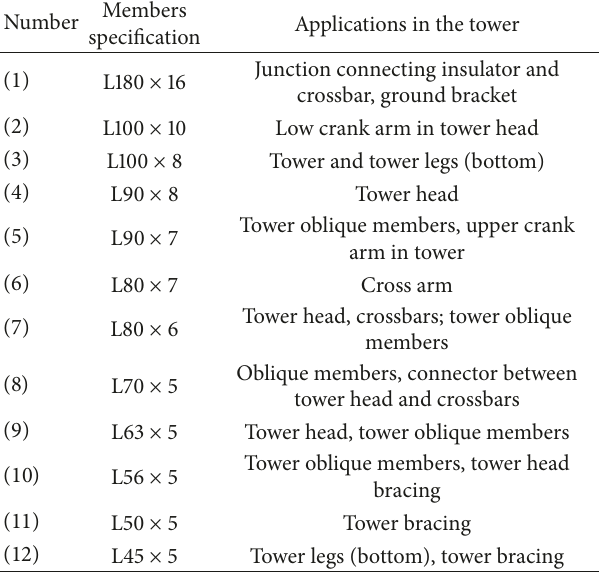
Table 1: Parameters of the main members of the transmission tow-